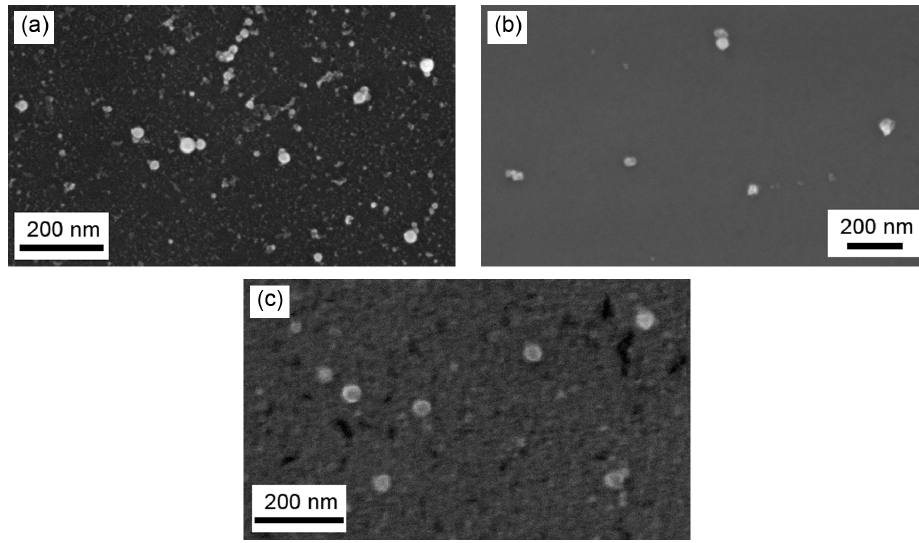
Figure 11. SEM images of ( a ) Al 2 O 3 ; ( b ) TiO 2 and ( c ) SiO 2 nanoparticles in the suspensions prepared for this animal experiment.